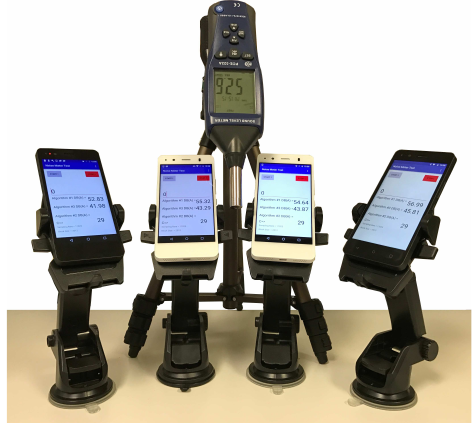
Figure 10. Smartphone same models used for testing.